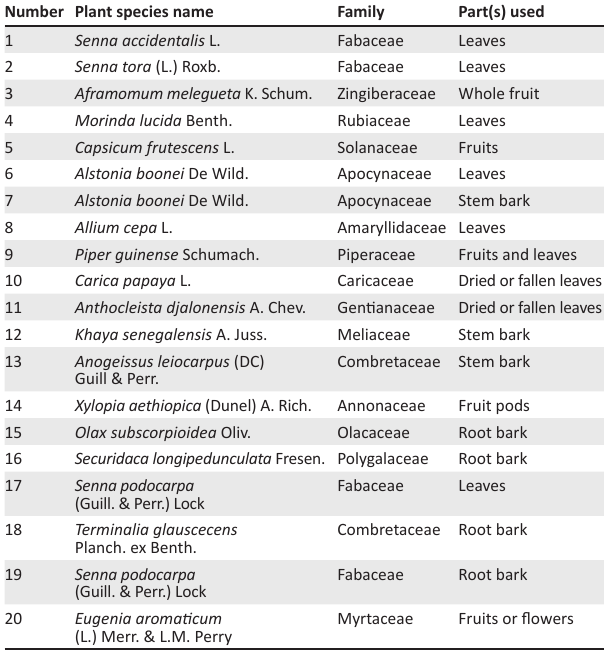
TABLE 11: Names of plants and their parts used for the formulation of traditional oral powdered herbal formulations for the treatment of malaria fever in Ogbomoso,